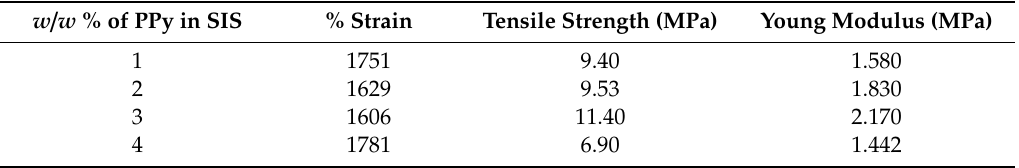
Table 3. Mechanical properties of di ff erent w / w % MoO 3 / PPy / SIS nanocomposites. w / w % of PPy in